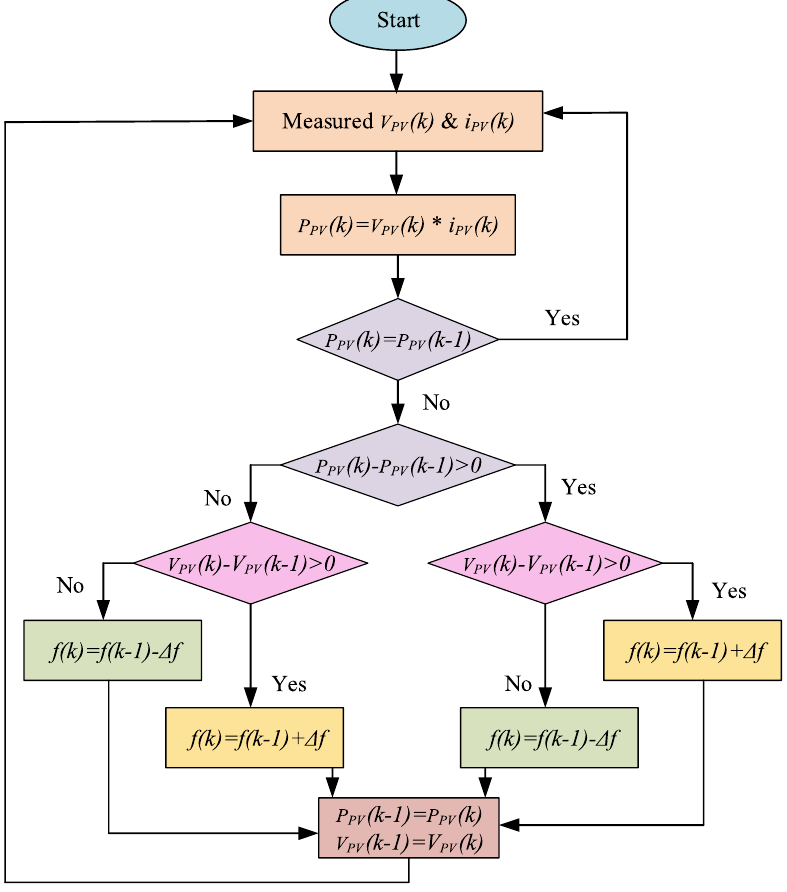
Figure 9. Perturb and Observe (P&O) MPPT